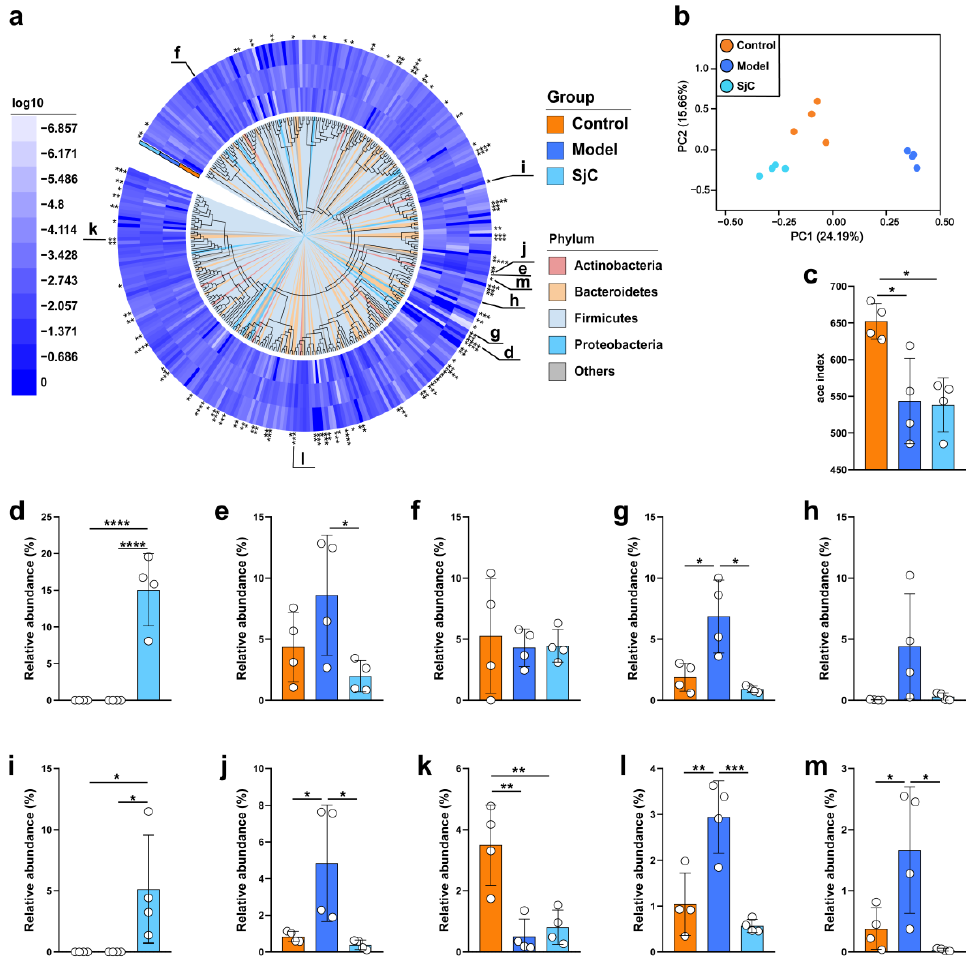
Figure 3. Metagenomic sequencing analysis revealed the effect of SjC administration on intestinal microbiota composition of HFD-fed mice. ( a ) Gut microbiota composition at the MAG level. The phylogenomic tree was drawn according to the core genes of each MAG. A total of 335 intestinal bacterial MAGs were detected and the average relative abundance of MAG in different populations was shown in the phylogenomic tree. ( b ) Principal component analysis (PCA) of gut microbiota composition at the species level. ( c ) Ace index of gut microbiota. Relative abundance of ( d ) Bacillales bin.293 , ( e ) Atopobiaceae bin.72 , ( f ) Lachnospiraceae bin.326 , ( g ) Desulfovibrionaceae bin.33 , ( h ) Akkermansia muciniphila bin.80 , ( i ) Helicobacteraceae bin.50 , ( j ) Bifidobacterium pseudolongum bin.53 , ( k ) Eubacteriales bin.324 , ( l ) Bacteroidales bin.271 , and ( m ) Atopobiaceae bacterium P1 bin.46 . All data are expressed by mean ± SEM ( n = 4). One-way ANOVA and Tukey multiple comparison analysis were used to analyze the significance between multiple groups, * p < 0.05; ** p < 0.01; *** p < 0.001; **** p <